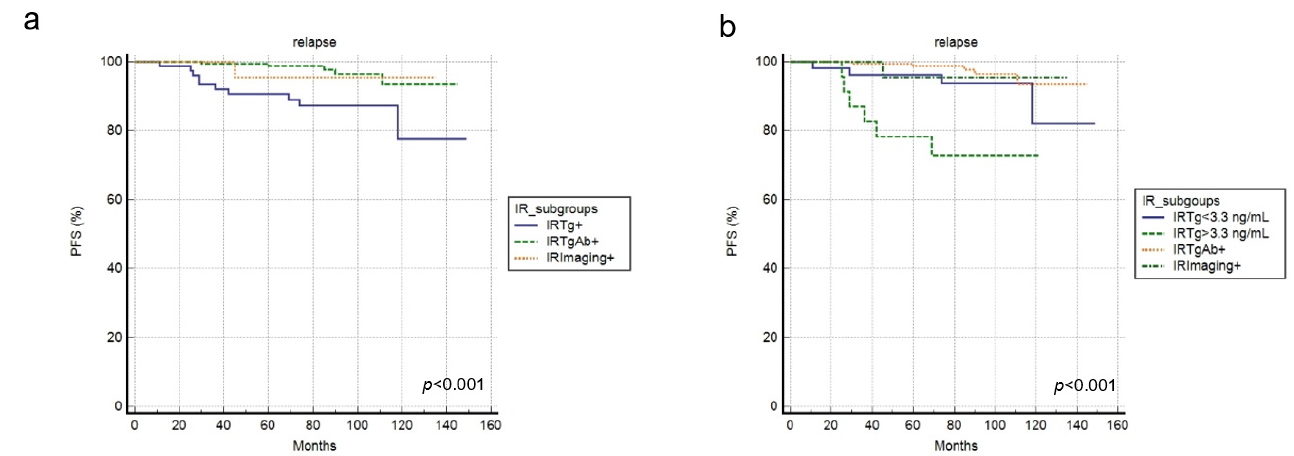
Figure 4. PFS curves according to IR subgroups and sTg level. ( a ) Kaplan Meier curve analyzing the three IR subgroups. ( b ) Kaplan Meier curve analyzing the four IR subgroups.